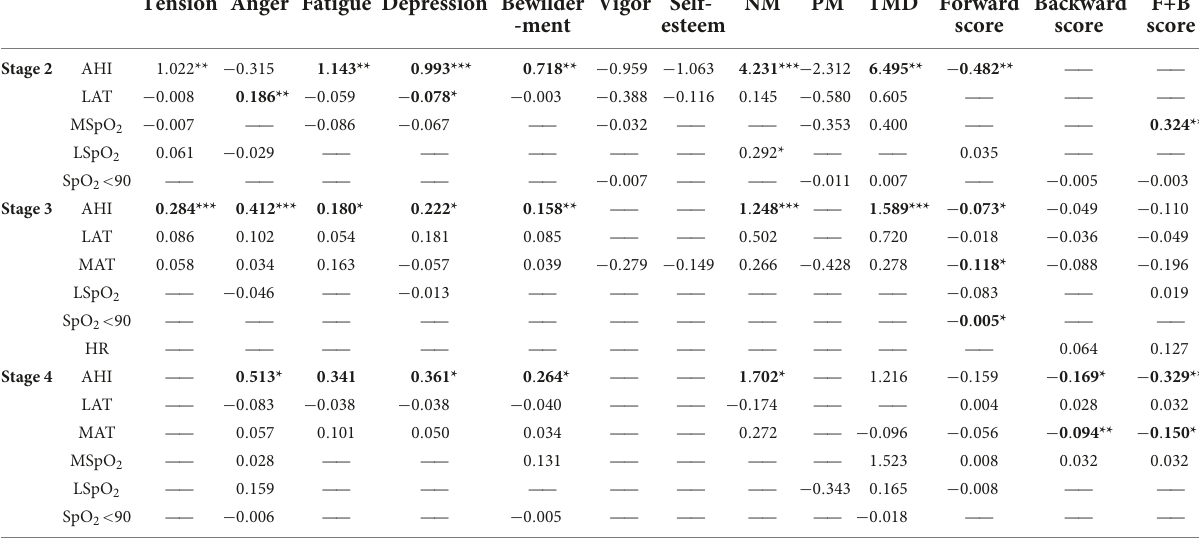
TABLE 3 Multiple linear regression analyses for the prediction of short-term memory and mood states from sleep parameters of volunteers (B). B Tension Anger Fatigue Depression Bewilder